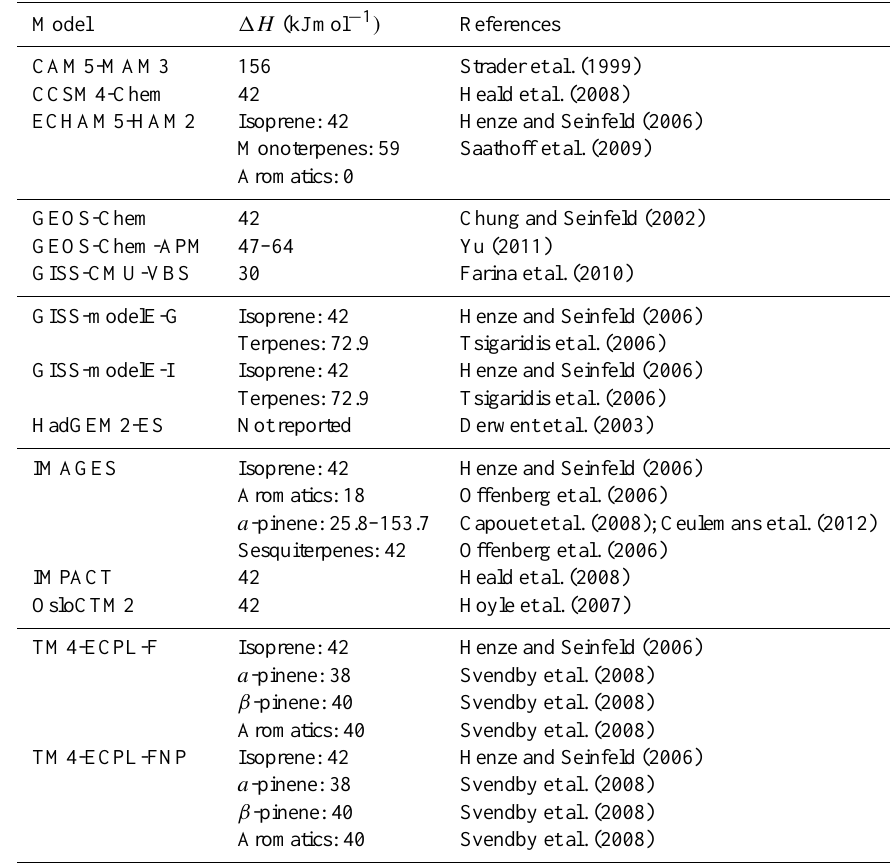
Table 6. Enthalpies of vaporization used by the models that include semi-volatile OA.